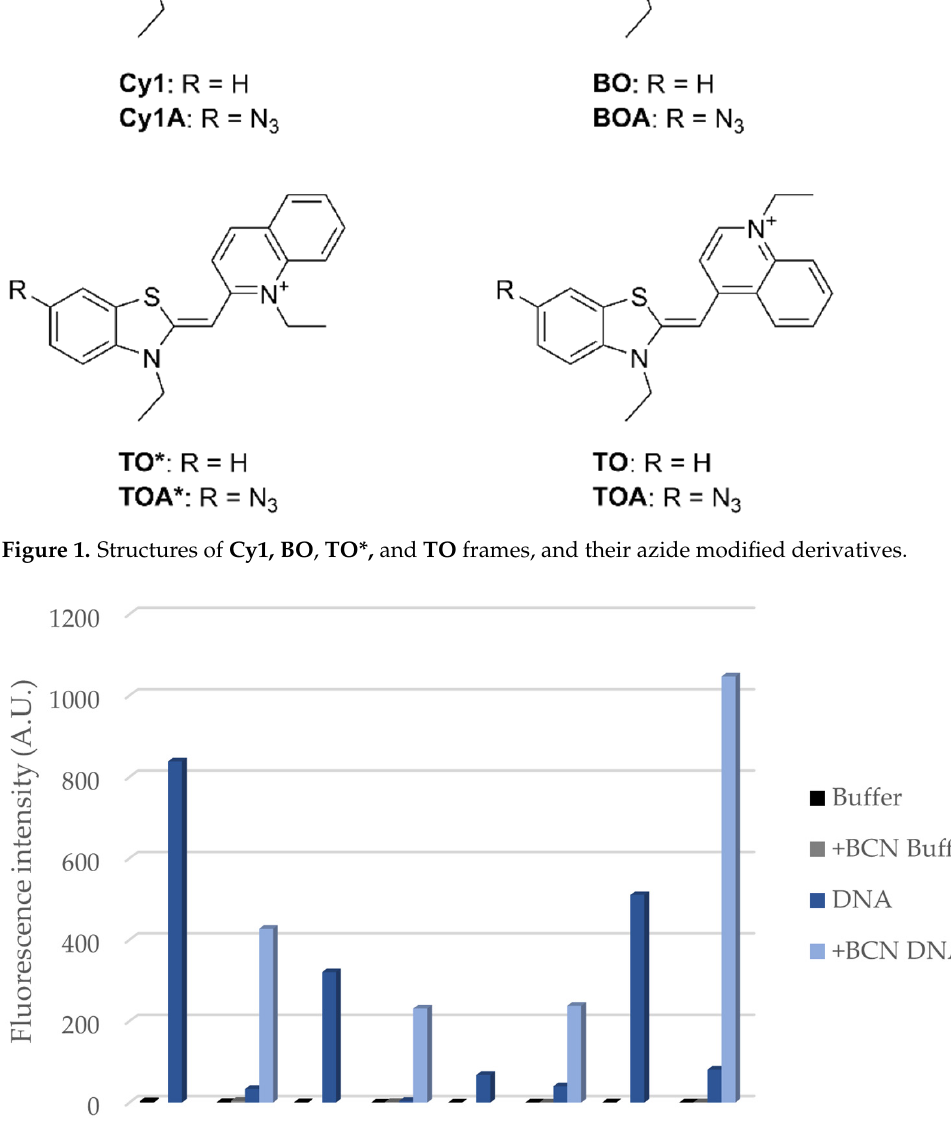
Table 1. Fluorescence quantum yields of Cy1, BO , TO*, and TO frames, their azide modified deriv- atives, and the BCN conjugates of the azides in the absence and presence of DNA. +BCN +BCN Φ PBS Φ DNA Φ PBS Φ DNA Cy1 0.0028 - 0.41 - Cy1A 0.0014